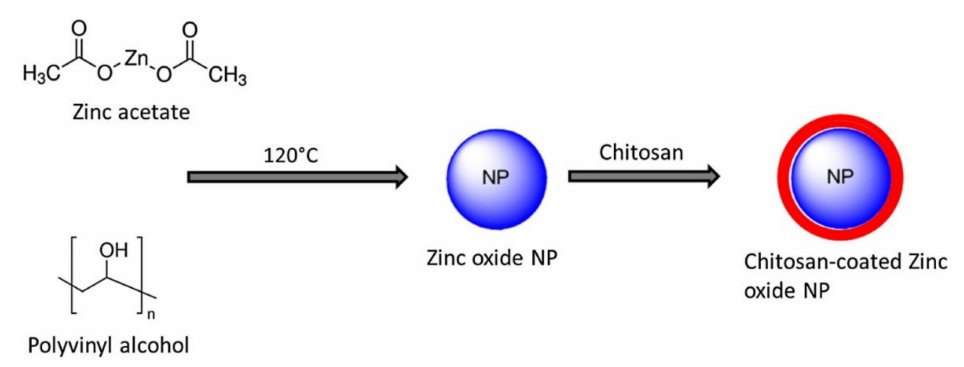
Figure 21. Schematic presentation of preparation chitosan-coated zinc oxide nanoparticles [136]. Reproduced with permission from Elsevier